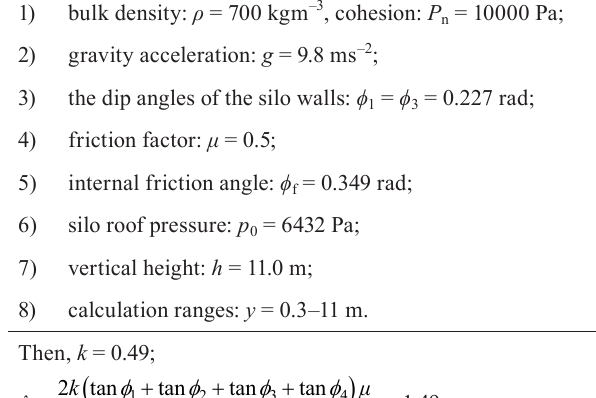
Fig. 4 The penetration tolerance δ and the penetration Δ (a) In non-contact state; (b) In contact state.